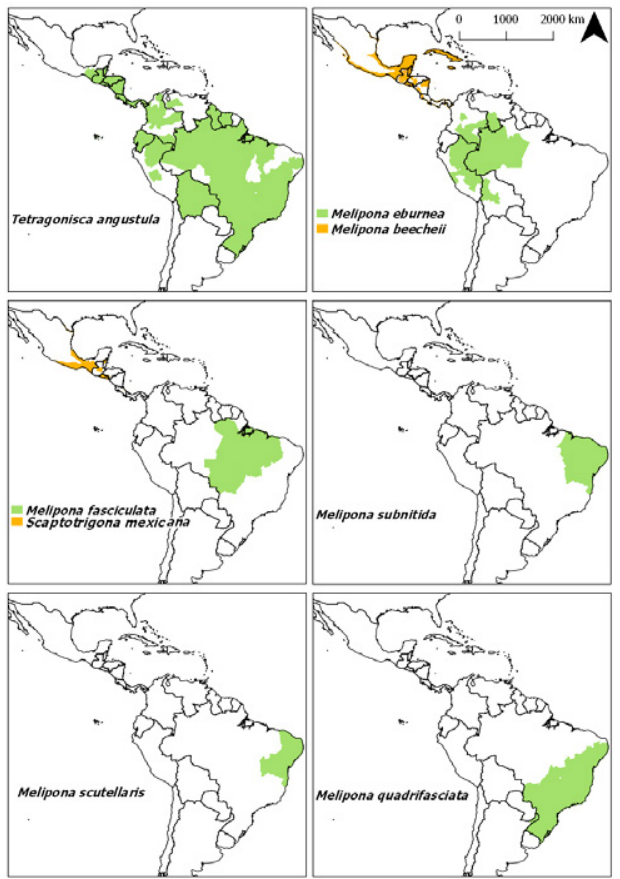
Fig 1 . Geographic distribution of the main species of stingless bees used in beekeeping in Tropical America. Data from Catalogue of Bees (Hymenoptera, Apoidea) in the Neotropical Region. Available on line at